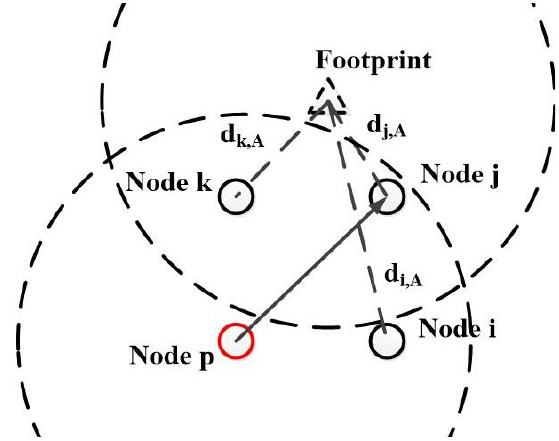
Figure 4. An example of data transmission in the redundancy reduction scheme based on TS